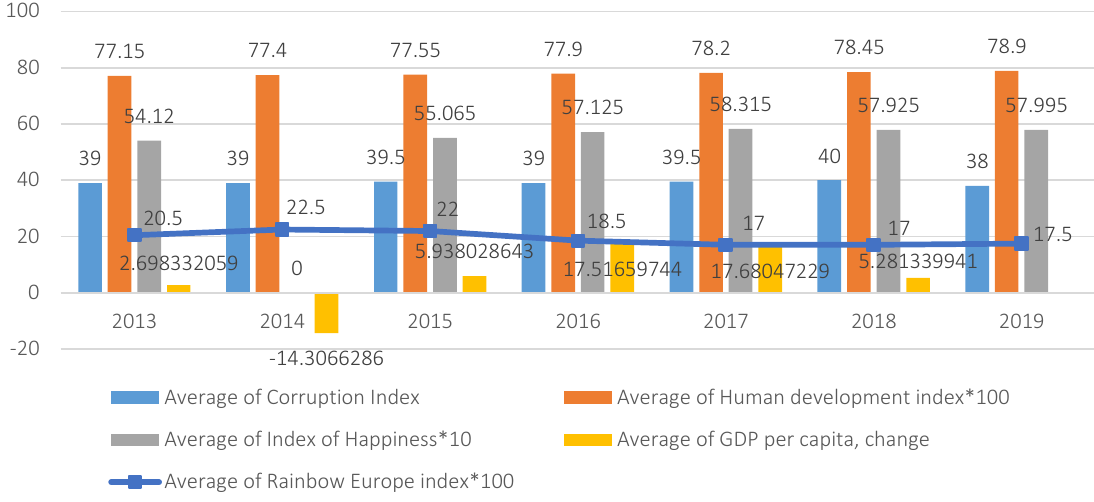
Figure 6. Average values of given indicators with a clear line of Rainbow Europe Index for Moldova and